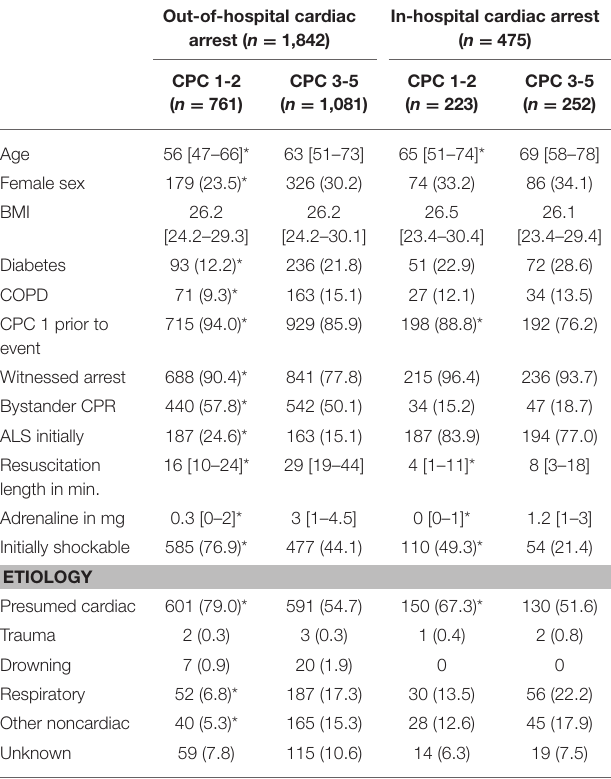
TABLE 1 | Baseline characteristics according to outcome at 30 days after admission.